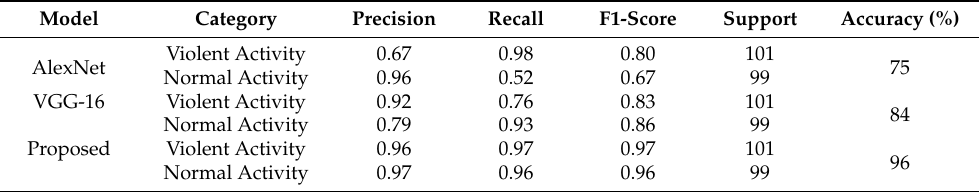
Table 7. Performance of the proposed sequential learning model on the Hockey Fight dataset.